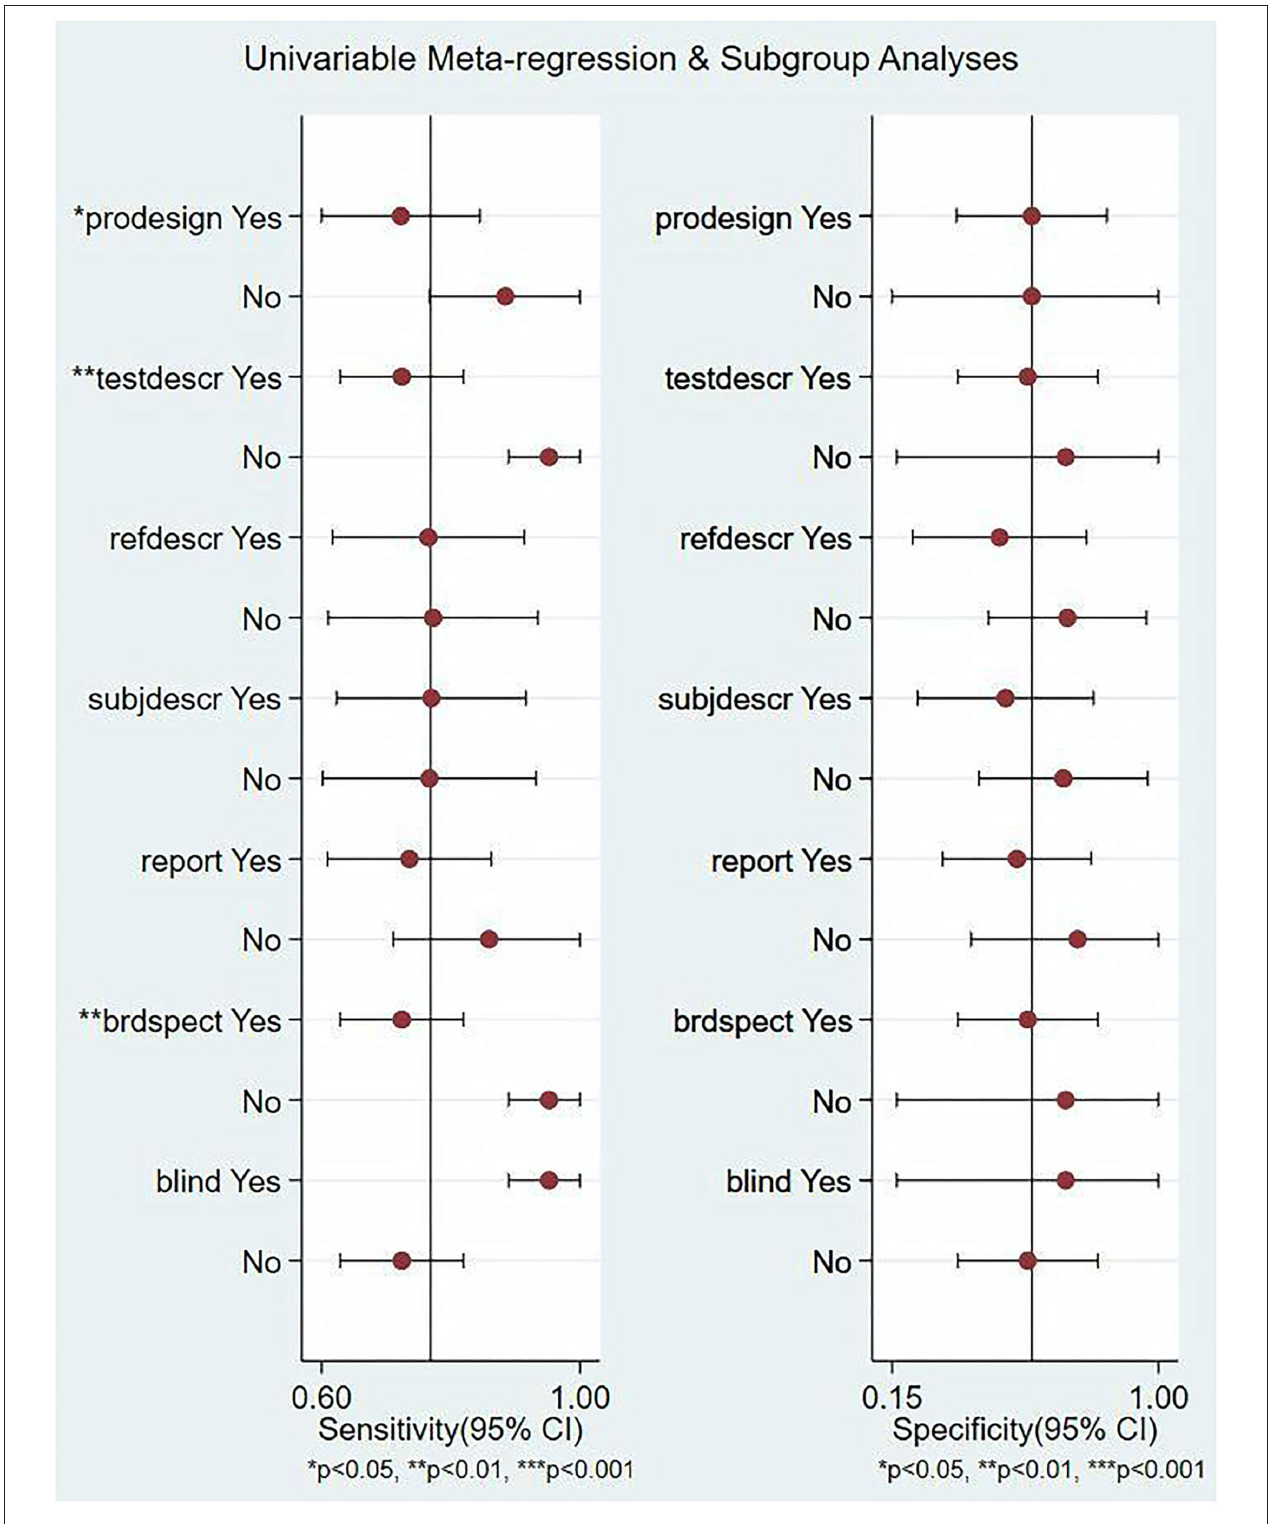
FIGURE 5 | Single-factor meta-regression and subgroup analysis. Prospective design: prodesign, testdescr: satisfactory description of the index test, subjdescr: adequate description of study subjects, refdescr: satisfactory description of ref test, and brdspect: broad spectrum of disease 1 . 1 The following variables used to adjust whether included studied met these